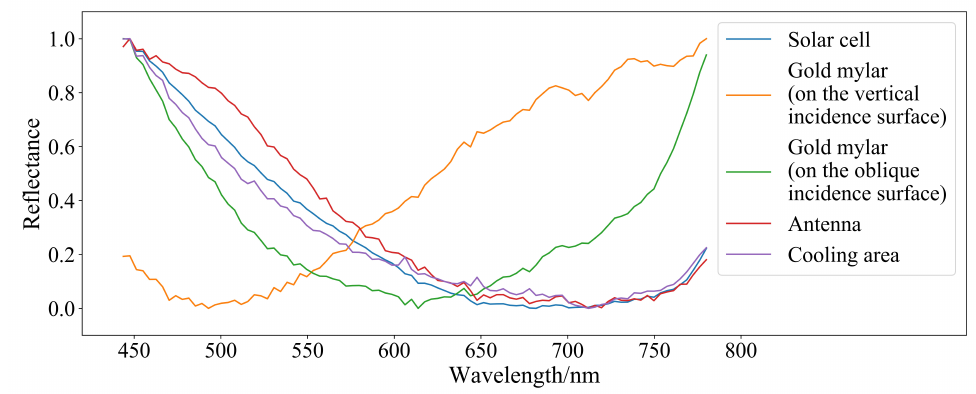
Figure 13. Examples of normalized materials’ spectra in the measured data.